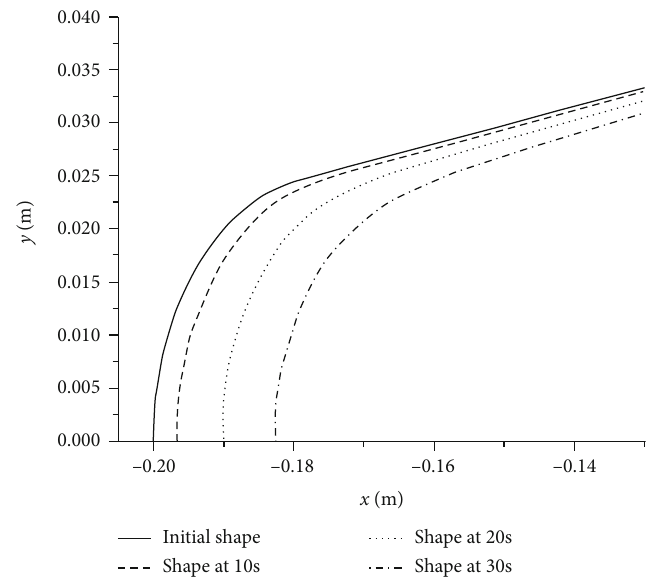
Figure 19: Ablation morphology of the leading